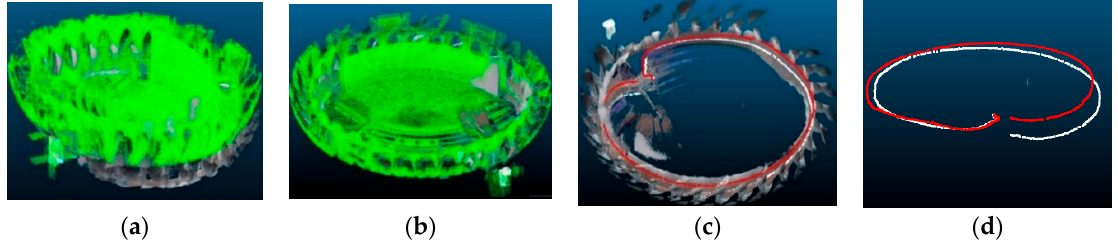
Figure 16. ( a ) Registration between models constructed by ORB-SLAM2 and LiDAR point cloud data model rendered in green. ( b ) Registration between models constructed by the proposed method and LiDAR point cloud data. ( c ) Sparse map constructed by the proposed method with camera trajectory overlay. ( d ) Comparison of the camera trajectories: camera trajectories produced by ORB-SLAM2 and the proposed method are shown in white and red, respectively. Table 6. Statistical results of matching error between the sparse maps generated by the two methods and the ground truth LiDAR data in closed round hall.